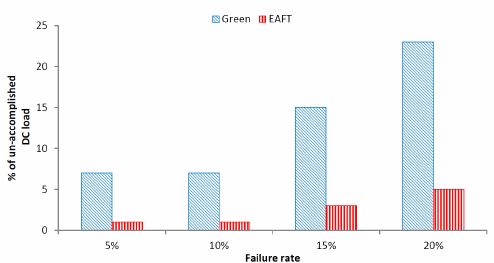
Figure 5. Failure Impact on DC Load.